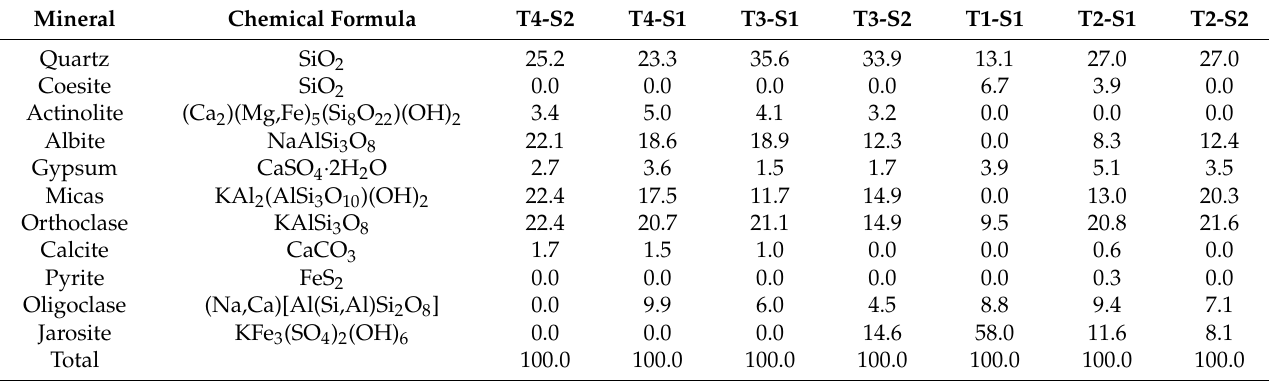
Table A1. XRD Results for the October 2018 ground survey, including mineral identification, chemical formulas, and modal percent weight. Trace phase grouping definitions were based on weight percentage ranges, where greater than 30 were considered major phases, less than 30 and greater than 10 were considered moderate, less than 10 and greater than 2 were considered minor, and less than 2 were considered trace phases. When peak to background ratios were low, the detection limit was 2 wt%, and when peak to background ratio was high, the detection limit could be as low as 0.5 wt%. Each sample was ground for five minutes in a McCrone Micronizing Mill using reagent alcohol to reduce particles to between 5 and 10 µ m.